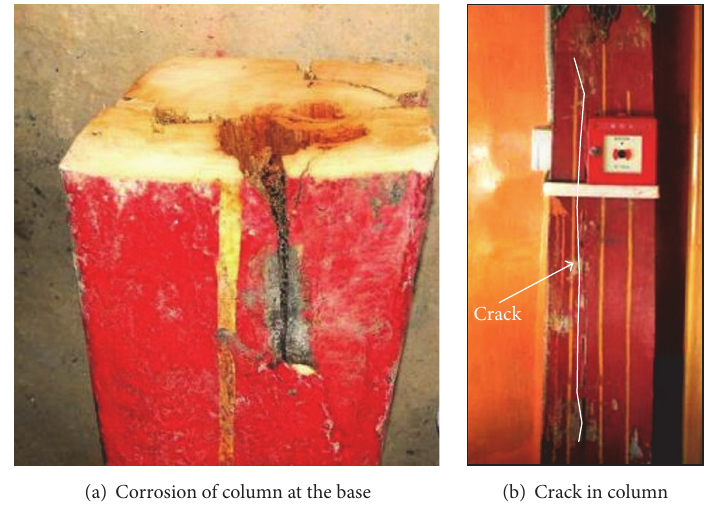
Figure 16: Damage of column.